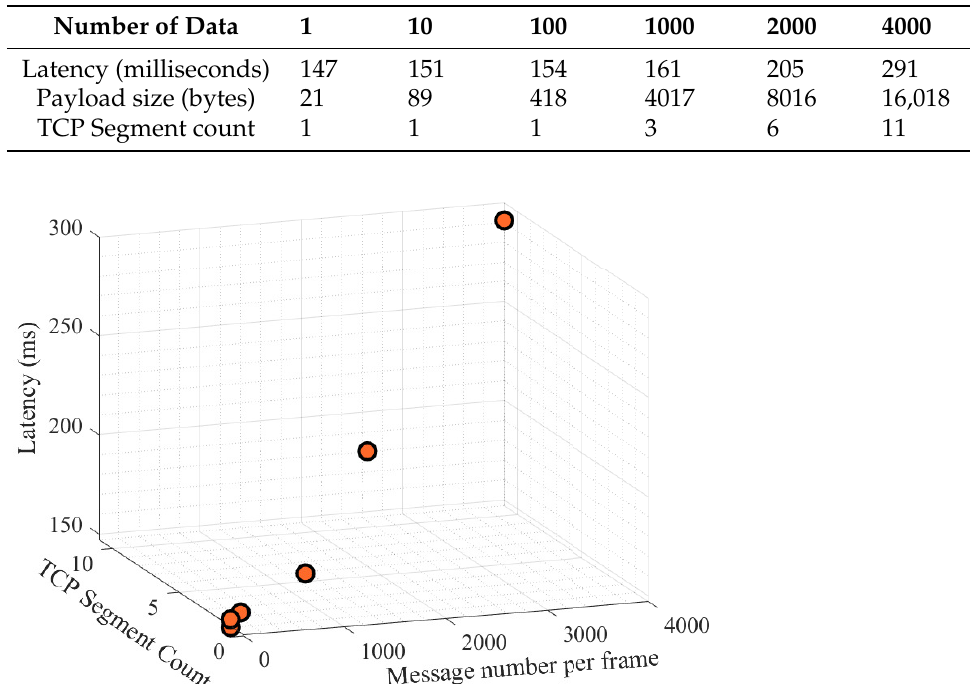
Figure 10. MQTT end-to-end latency results. The effect of TCP segmentation is clearly visible on the different measured latency